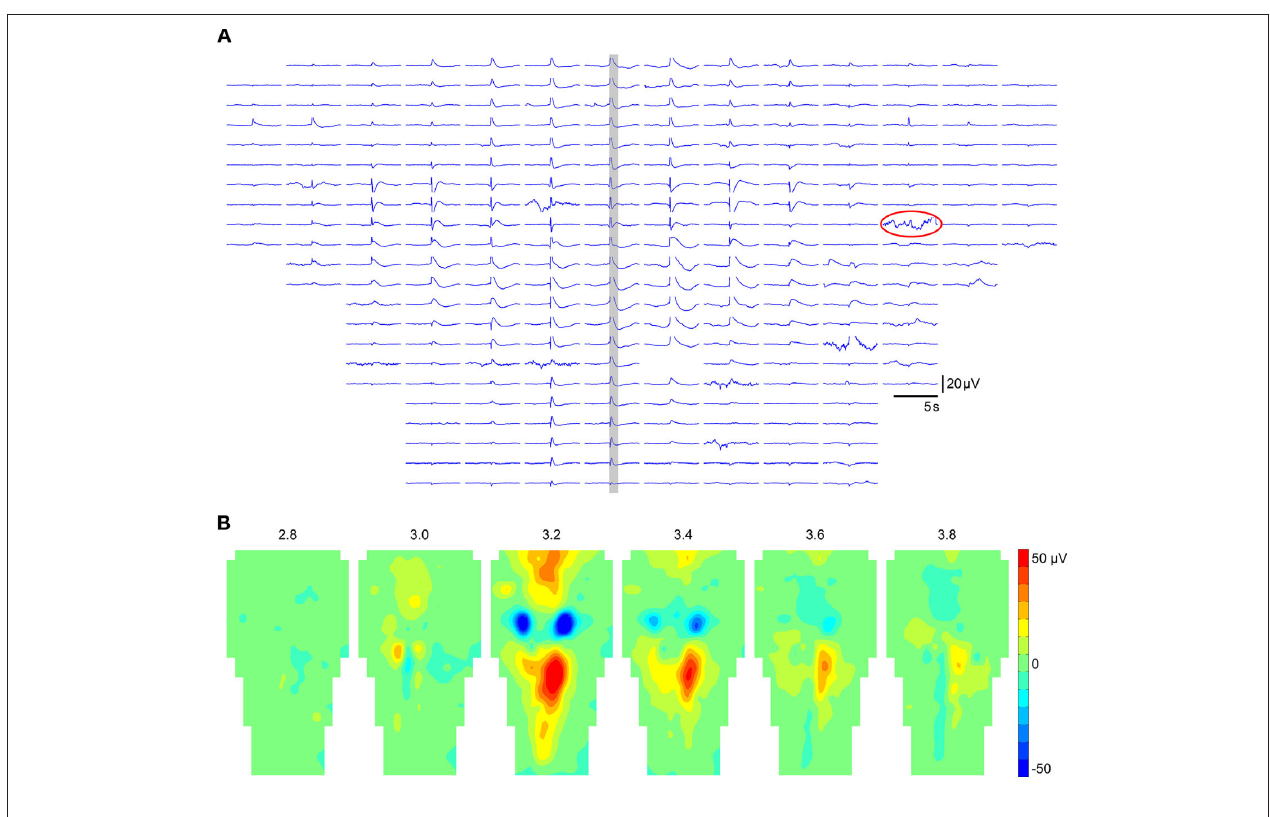
intervals. Note that one damaged electrode (circled in A) was disabled to construct the maps. Data displayed here were obtained from the averaging of 44 individual episodes expressing the same spatiotemporal